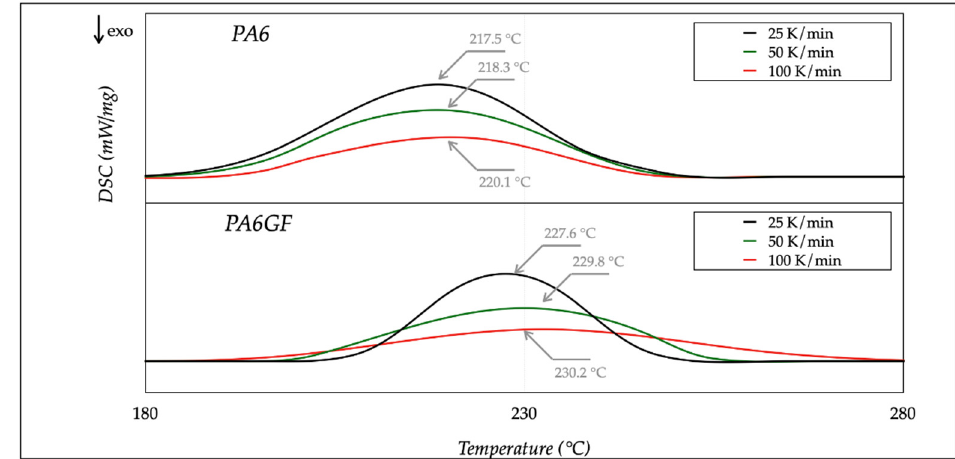
Figure 3. DSC thermograms: heating steps at different rates.